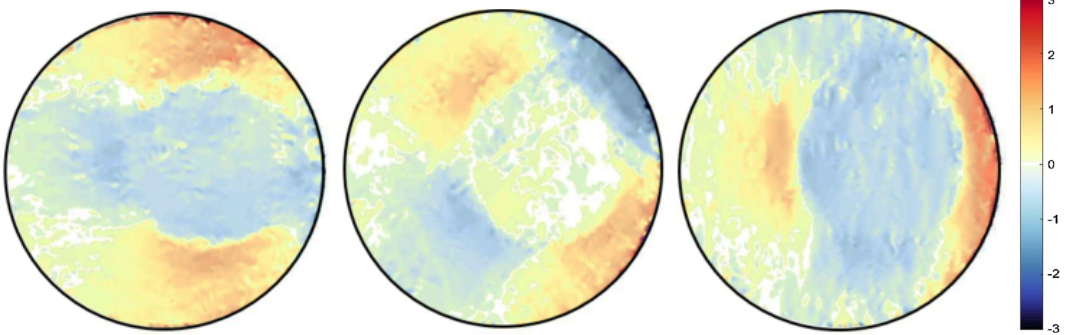
Figure 8. Ring-and-plug reconstructed strain field ε xx , ε xy , ε yy for unstructured mesh type